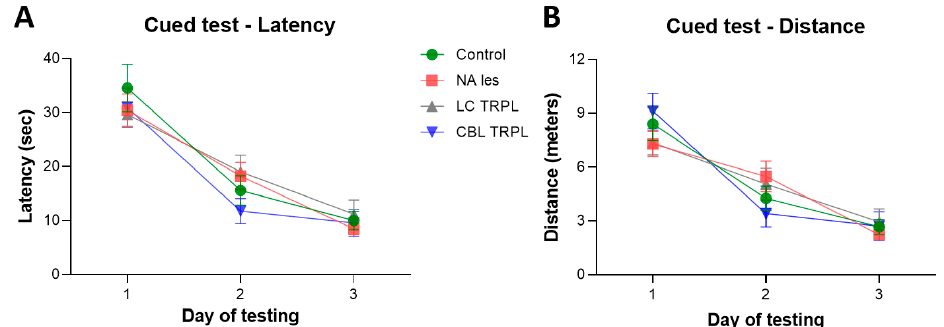
Figure 1. Performance in the cued version of the Morris Water Maze test. All animals in the Control, Lesioned (NA less), LC-transplanted (LC TRPL) and CBL-transplanted (CBL TRPL) groups, exhibited similar escape latencies ( A ) and swim distances ( B ). Each point represents the mean value ± SEM for the block of four trials administered each day.